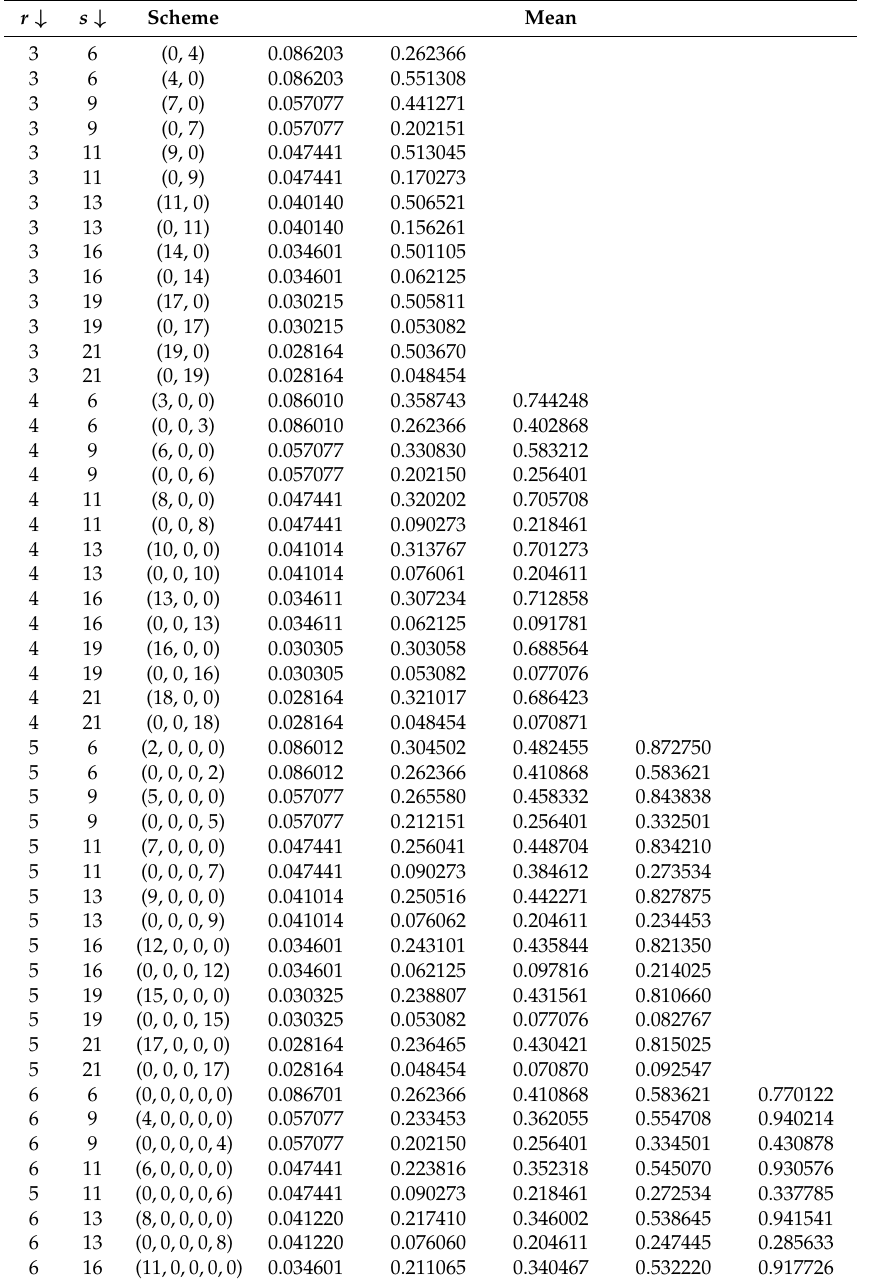
Table 1. Means of two parameter RK distribution for different values of parameters, e.g., µ = 2 and λ =